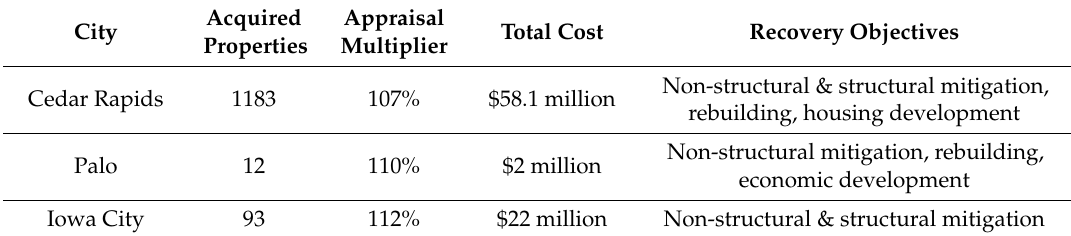
Table 2. Property acquisition by